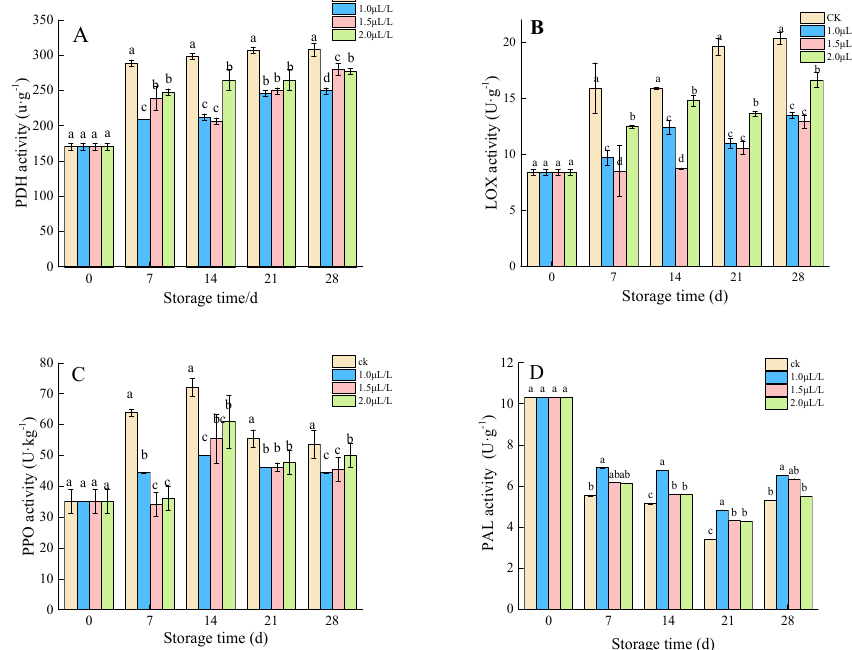
Figure 5. Effects of 1-MCP on PDH activity ( A ), LOX activity ( B ), PPO activity ( C ), and PAL activity ( D ). Different letters at each time point indicated a significant difference between treatments ( p < 0.05) by Duncan’s multiple range test.